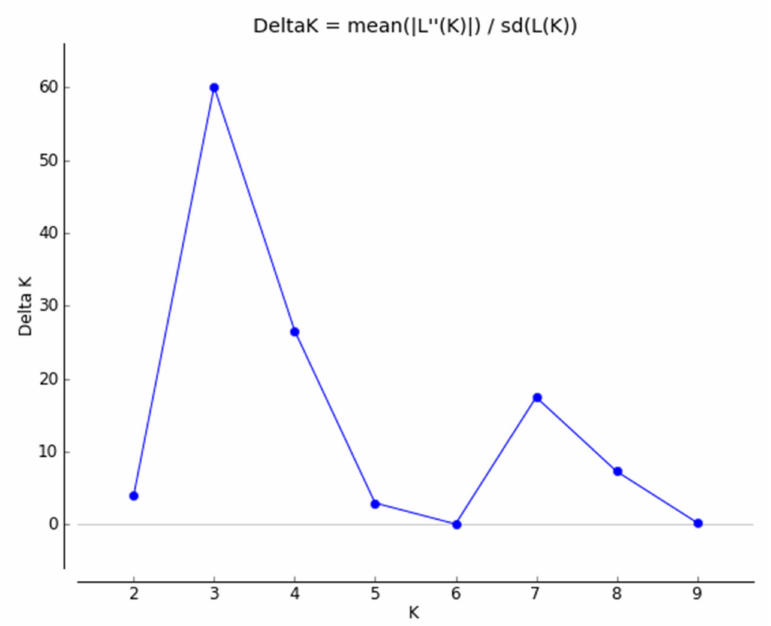
Figure 2. Magnitude of ∆ K as a function of K. The peak value of ∆ K was at K = 3, suggesting the existence of three main groups and an admixed group in the 200 accessions of the native Perilla frutescens var. frutescens of Perilla